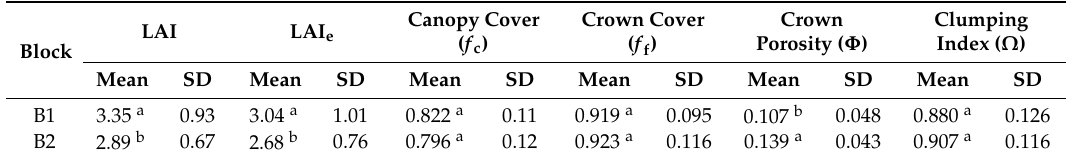
Table 2. Means and standard deviation (SD) of canopy architecture parameters for the two blocks. Di ff erent letters represent statistically significant di ff erences between samples using the Tukey studentized test with α = 0.05.